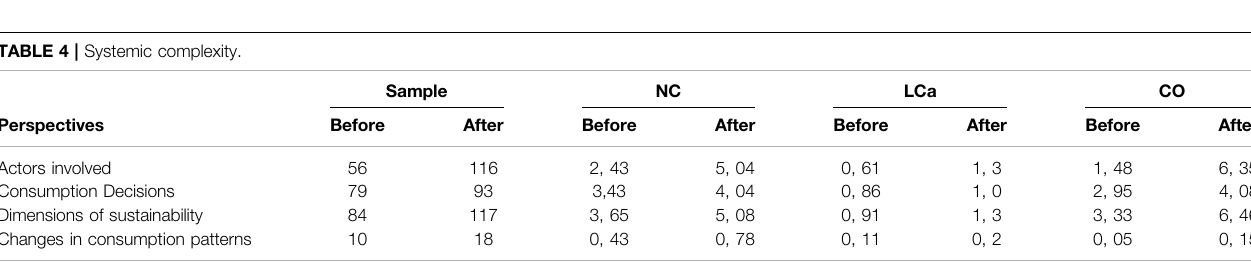
TABLE 4 | Systemic complexity.